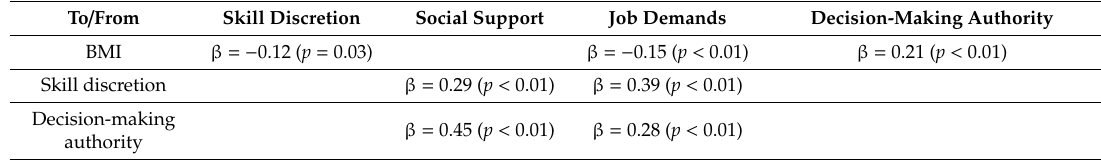
Table 1. Model 1. Direct e ff ects of the relationships between JCQ dimensions and BMI.